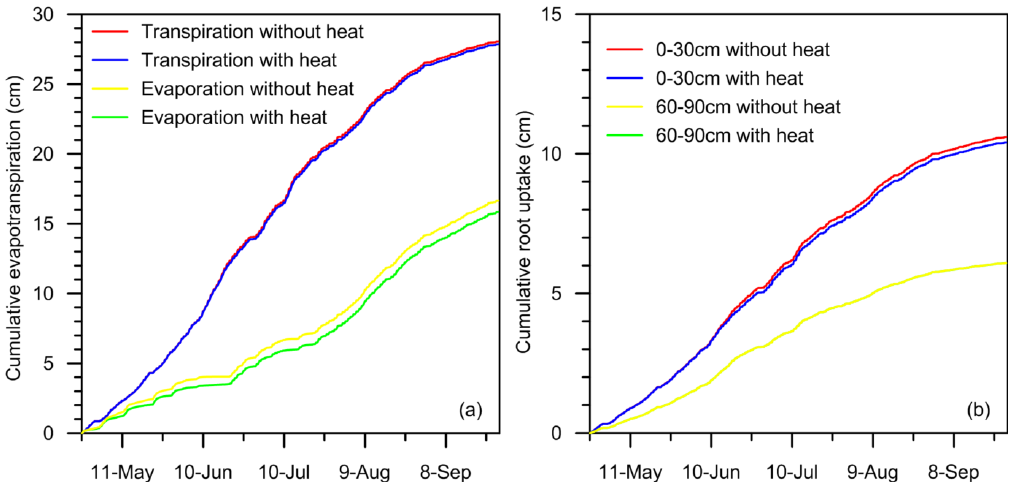
Figure 8. ( a ) Cumulative evapotranspiration; and ( b ) root water uptake for selected depth intervals with heat flow and without heat flow.